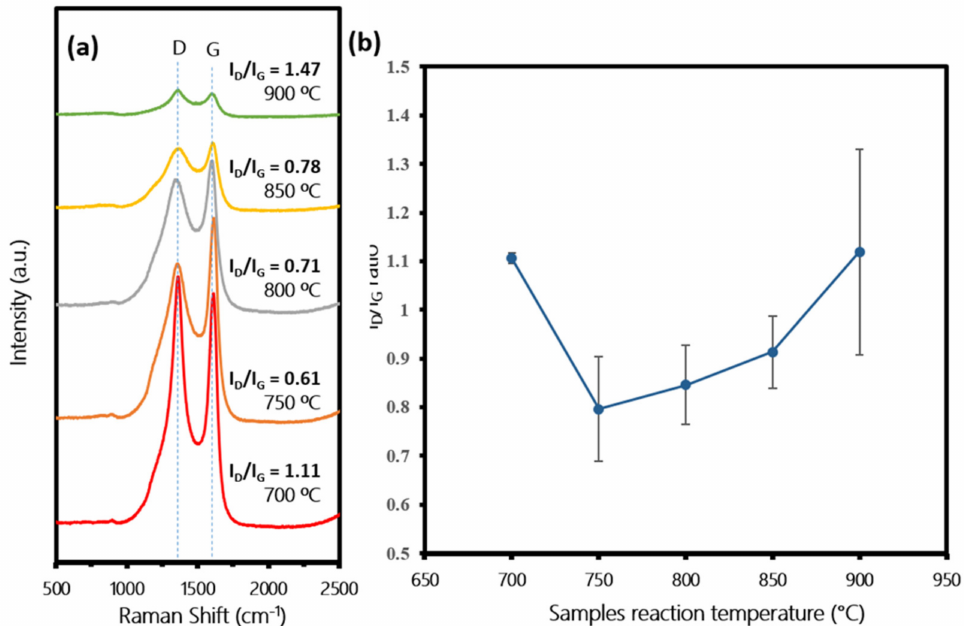
Figure 10. ( a ) Raman spectra of samples synthesized at various sample reaction temperatures of 700, 750, 800, 850 and 900 ◦ C. ( b ) Corresponding average I D /I G ratio,